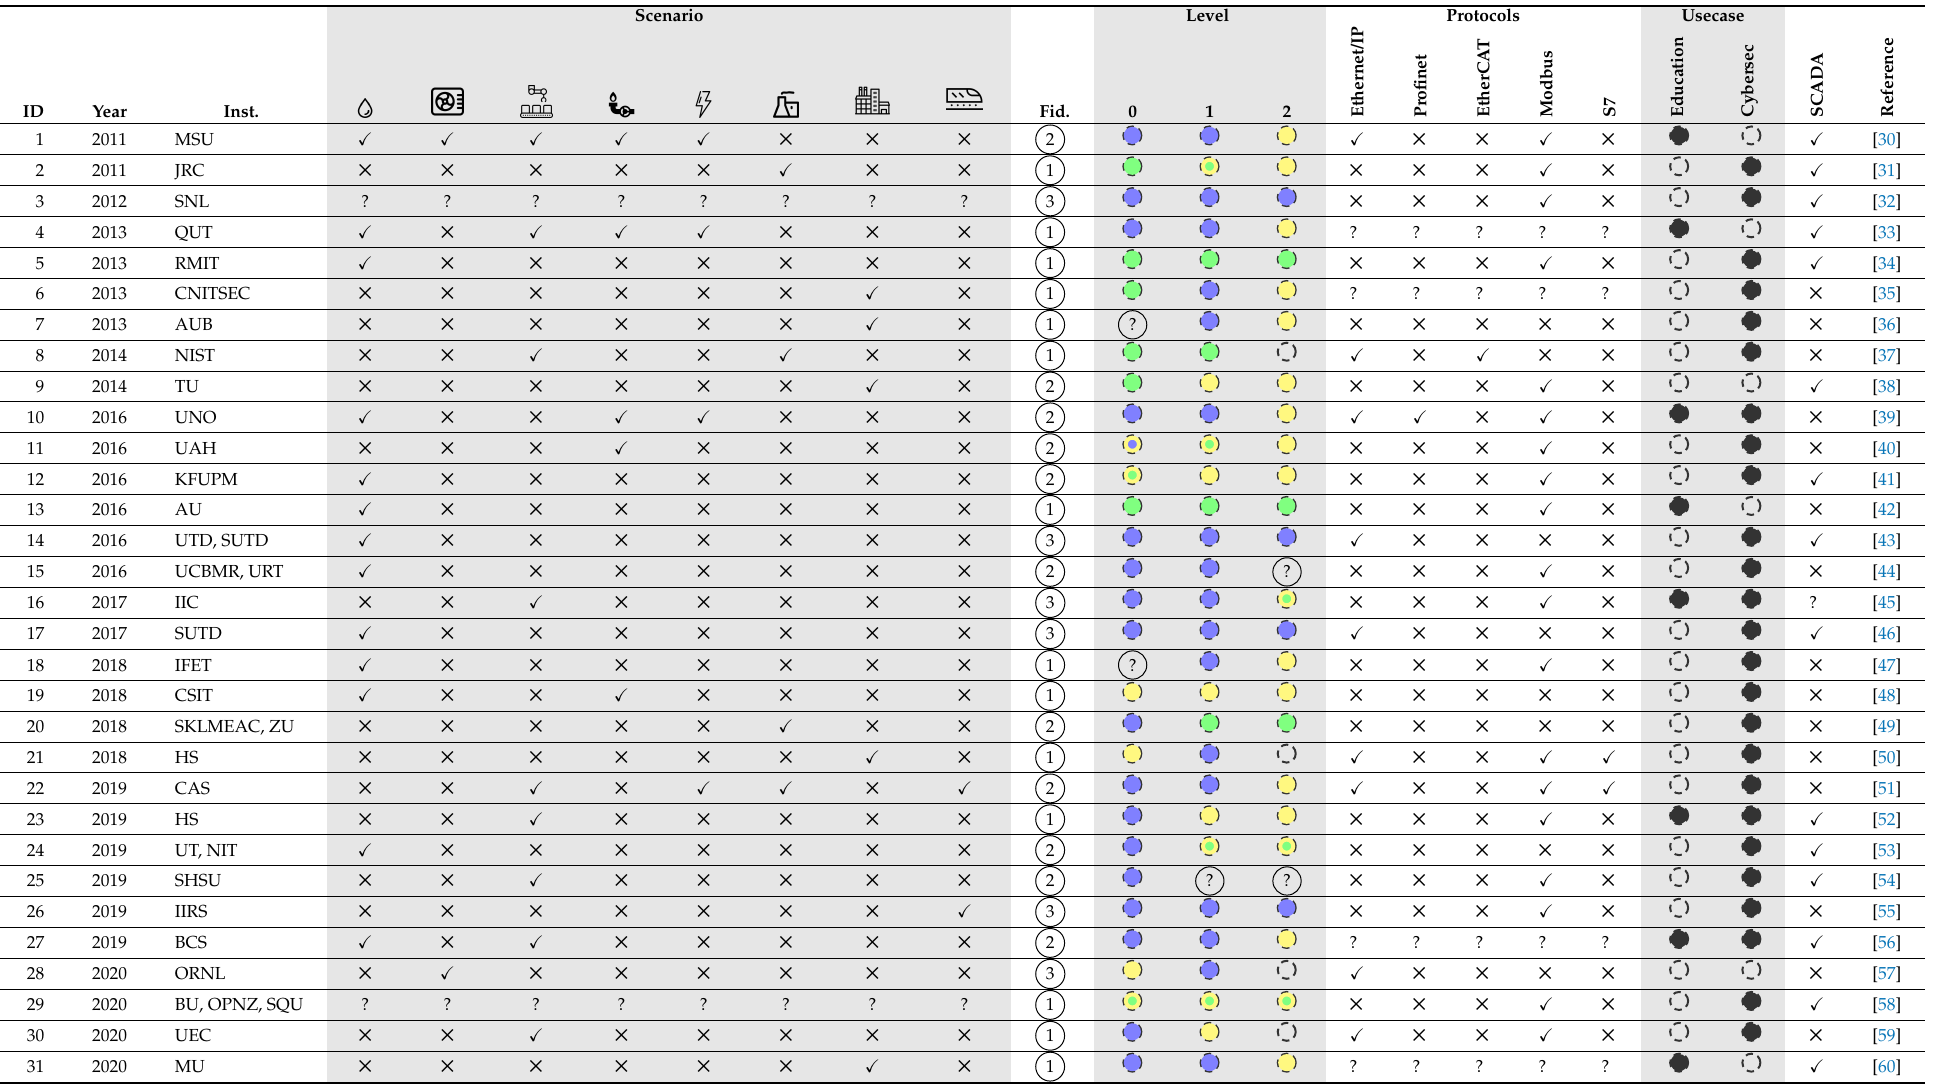
Table 1. Testbed